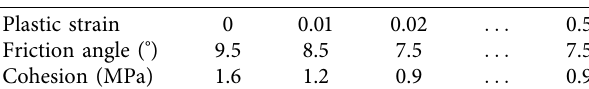
Table 2: Parameters of the strain softening model for coal